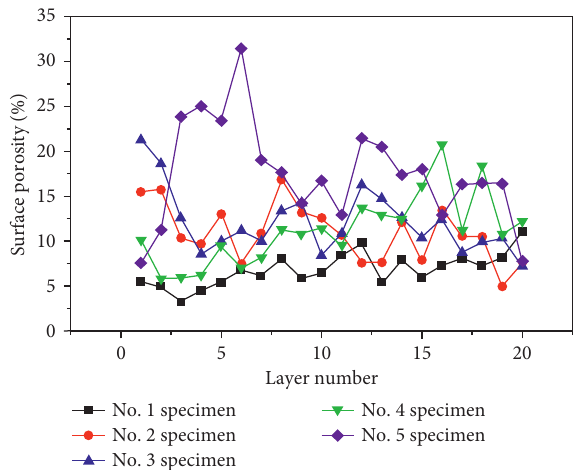
Figure 12: The porosity of RAPC based on CT